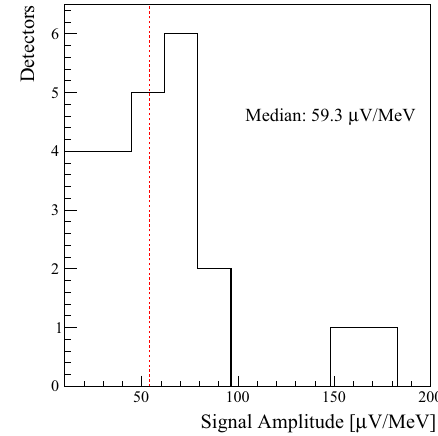
Fig. 26 Distribution of the ZnSe signal amplitudes for each